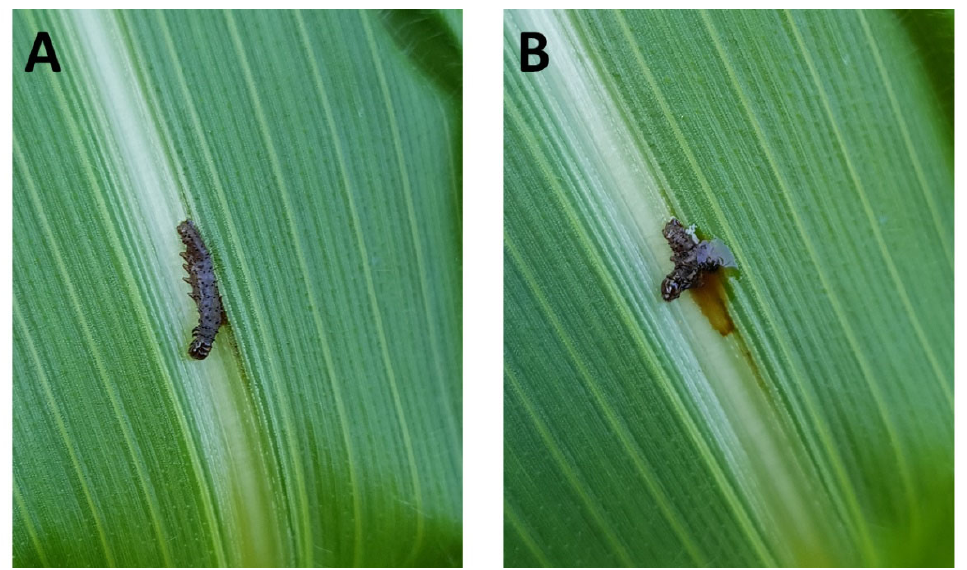
Figure 3. Representative dead Helicoverpa armigera larva infected with Ha NPV, photographed after field treatments, before ( A ) and after ( B ) being gently touched with a cotton flake.